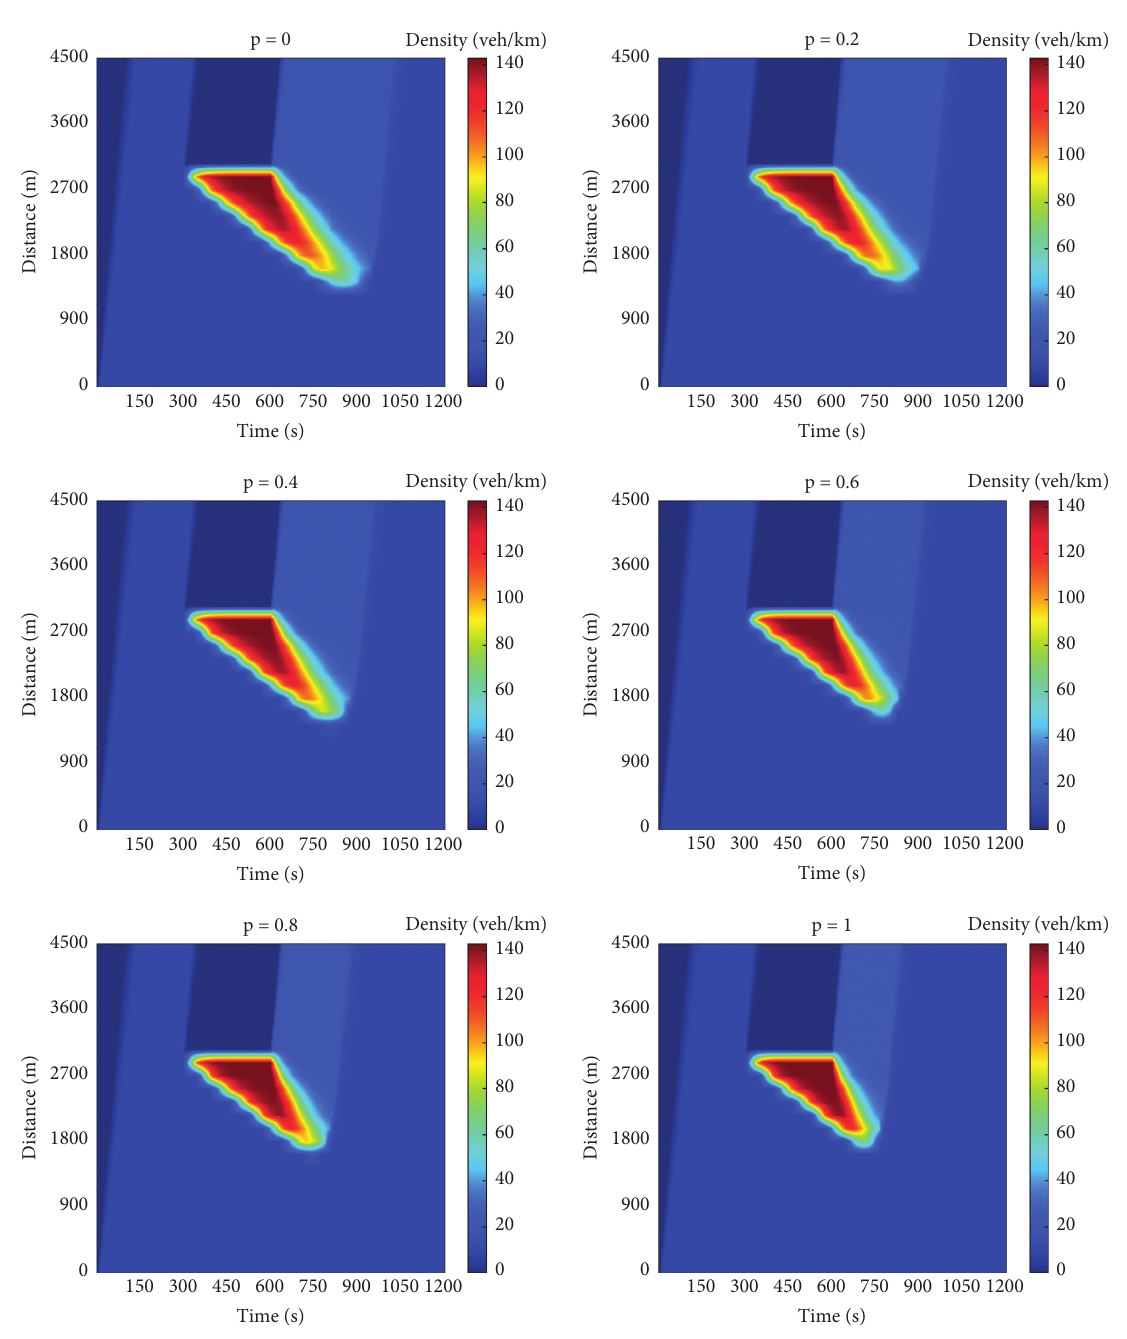
Figure 11: Density variation of